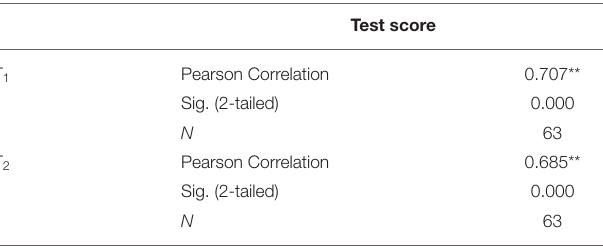
TABLE 6 | Correlation between emotional valence and test